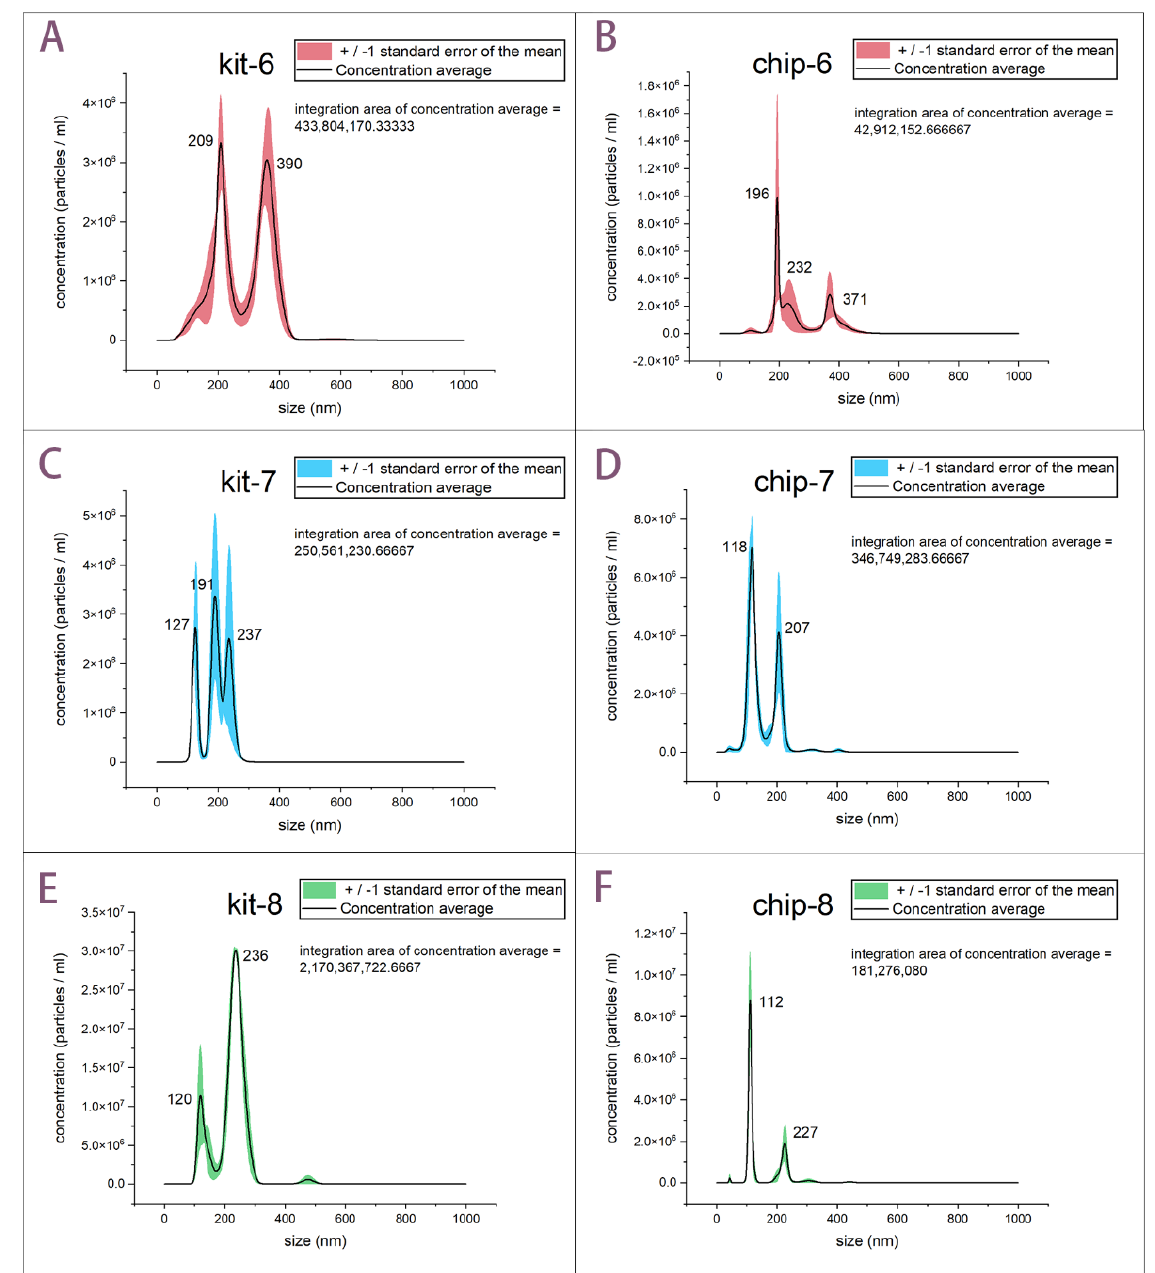
Figure 4. NTA of exosomes by using aptamer-based microfluidics and exoEasy Maxi Kit. ( A ) Aver- aged concentration/size distribution of exosomes collected from cell culture supernatant (passage-6) by using exoEasy Maxi Kit. ( B ) Averaged concentration/size distribution of exosomes collected from cell culture supernatant (passage-6) by using our device. Error bars indicated +/ − standard error of the mean. ( C , D ) are the data graphs from cell culture supernatant (passage-7). ( E , F ) are the data graphs from cell culture supernatant (passage-8).